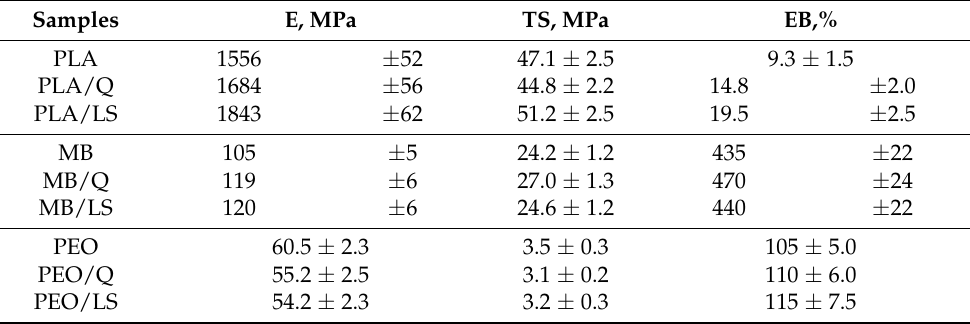
Table 7. Changes in the mechanical properties (elastic modulus, tensile strength, and elongation at break) before and after stabilization with quercetin additives (Q): Cyasorb and synthetic Light Stabilizers (LS) [78]. Samples